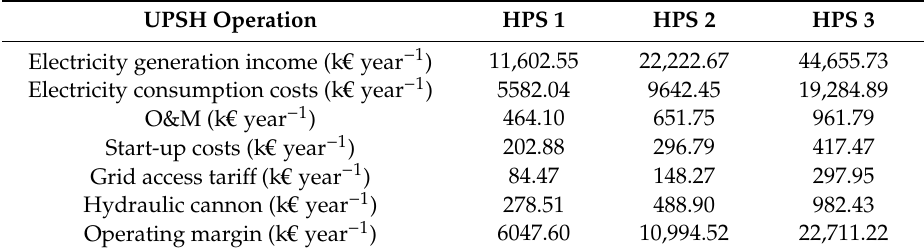
Table 2. Income and operation costs of HPS 1, HPS 2 and HPS 3, considering a DTC of 8 h. UPSH Operation HPS 1 HPS 2 HPS